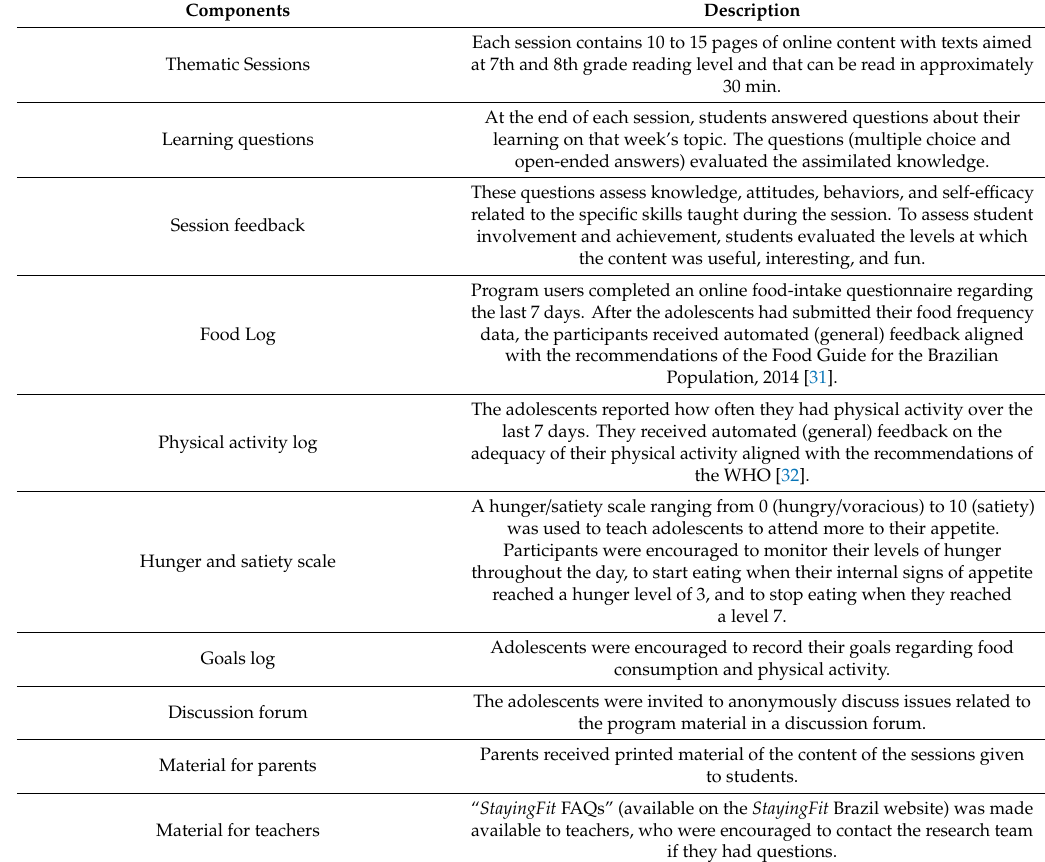
Table 1. Components that structure the virtual learning environment of StayingFit